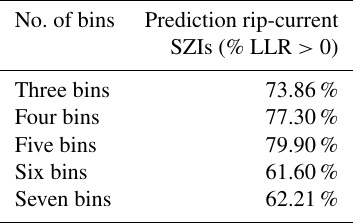
Table 4. The percentage of LLR > 0 for rip-current SZIs, indicating whether the prediction of the model is better than the prior proba- bility.